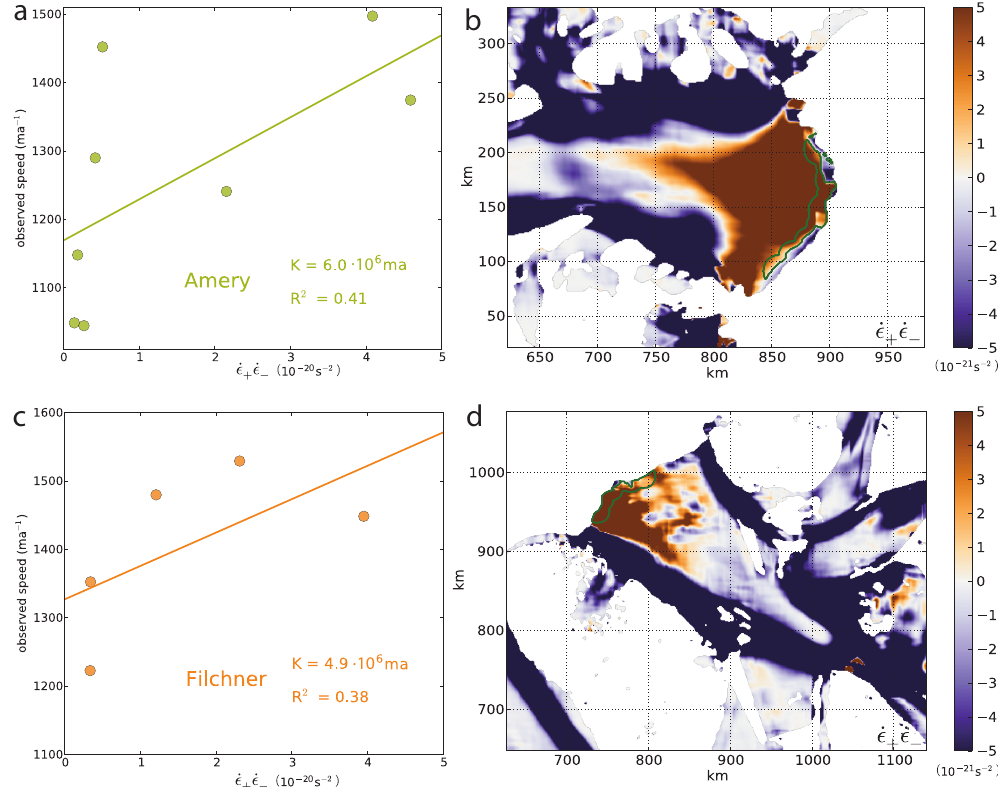
Fig. 4. Eigencalving relation for the comparably narrow topographies of Amery- and Filchner-ice shelves as derived from the surface velocity data set by Rignot et al.